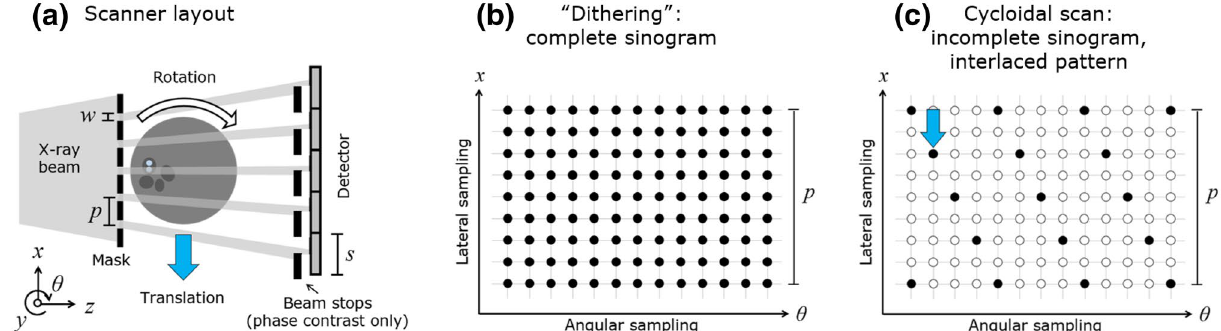
Figure 1. ( a ) Scanner layout (not to scale and extending uniformly into the y -direction), where p is the mask period and w is the aperture width of the mask; ( b ) Sinogram sampling pattern for a dithered acquisition, and ( c ) for a cycloidal acquisition. The sinogram grids are shown for a subset of angles and one mask period. The filled circles represent the sampled data points, while the empty circles represent the ones not sampled. This figure is adapted from 35